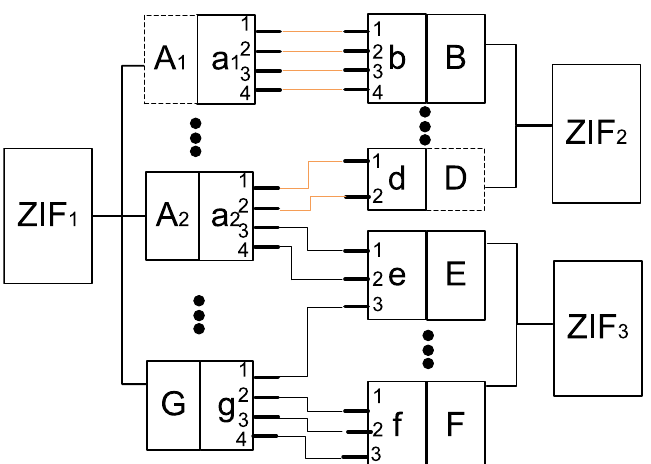
Fig. 8 Wrong connection between the test equipment and test nodes